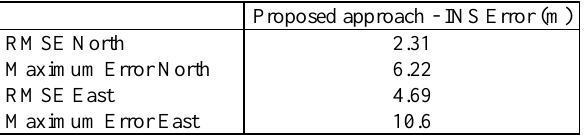
Table 5. Proposed approach performance errors during 260 Secs of GNSS signal